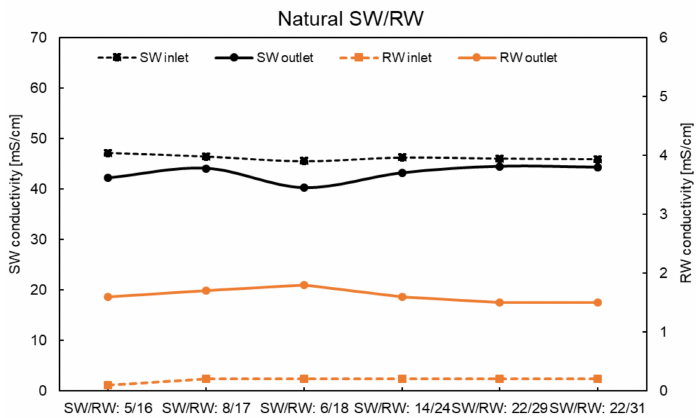
Figure A3. Conductivity of inlet and outlet solutions using the natural SW/RW at zero